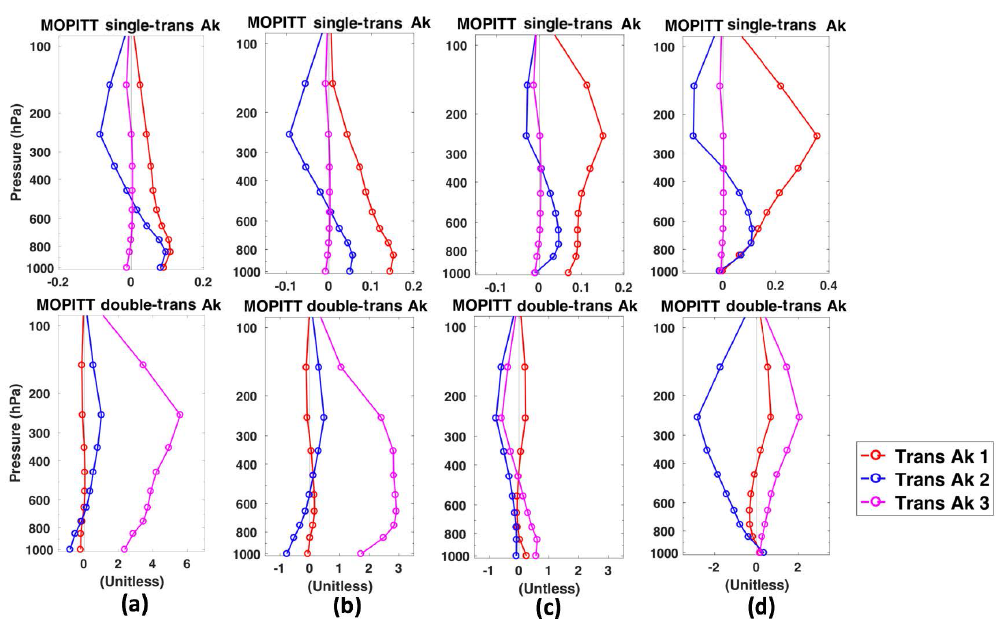
Figure 11. Same as the lower two rows of Fig. 4 except that this figure is for the retrieval discard experiments. Column (a) is for the full retrieval profile assimilation experiment and is the same as column (a) in Fig. 3. Column (b) is for the “reject top three” experiment in Table 2. Column (c) is for the “reject middle three” experiment. Column (d) is for the “reject bottom three” experiment. Notice that the range of the abscissa is reduced from column (a) to columns (b–d)